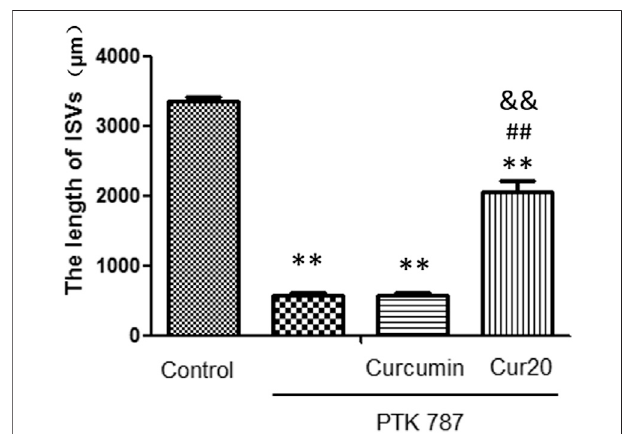
FIGURE3| Cur20restoredtheformationofintersegmentalvessels(ISV) in angiogenesis inhibition model of zebra fi sh. After 20 hpf (hours post fertilization),zebra fi shembryosweretreatedwithdrugsfor24 h,andtheeffect of drugs on the ISVs of zebra fi sh was observed and calculated using Image Pro Plus software. The experimental data was expressed by mean ± SD, n (cid:2) 16.**, p ＜ 0.01vs.controlgroup;## p ＜ 0.01vsmodelgroup (PTK787 group); and p ＜ 0.01 vs Curcumin